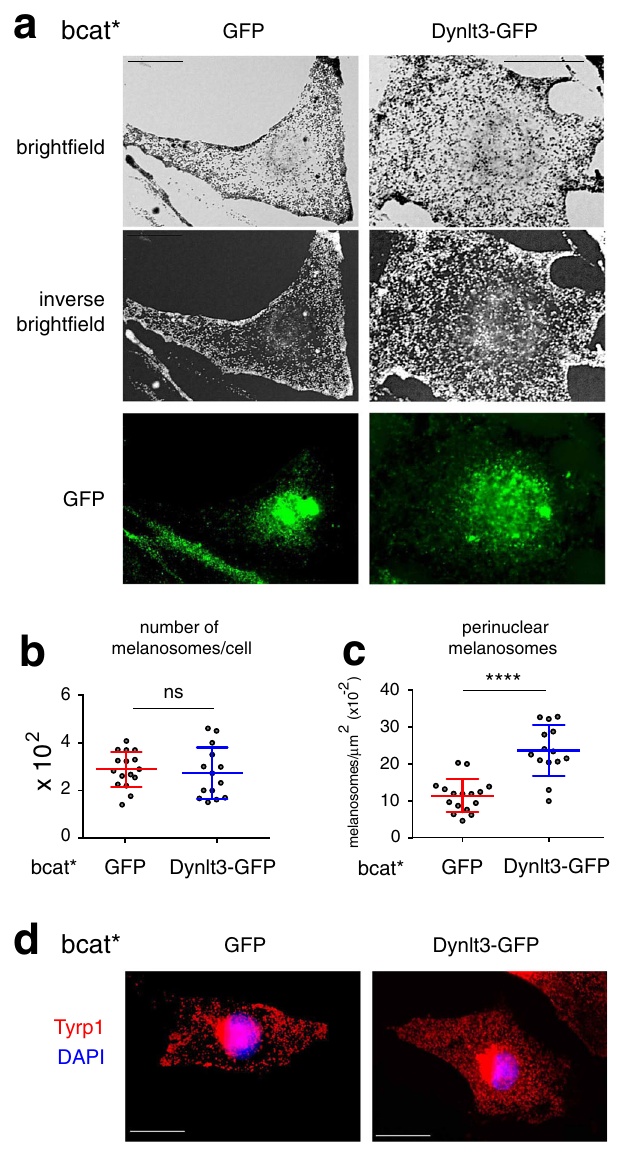
Fig. 4 Overexpression of Dynlt3 redistributes melanosomes in bcat* melanocytes. a Bright fi eld, inverse bright fi eld, and GFP images of bcat* melanocytes transiently expressing GFP or GFP-tagged Dynlt3. Bar, 20 μ m. b Quanti fi cation of the total number of pigmented melanosomes in